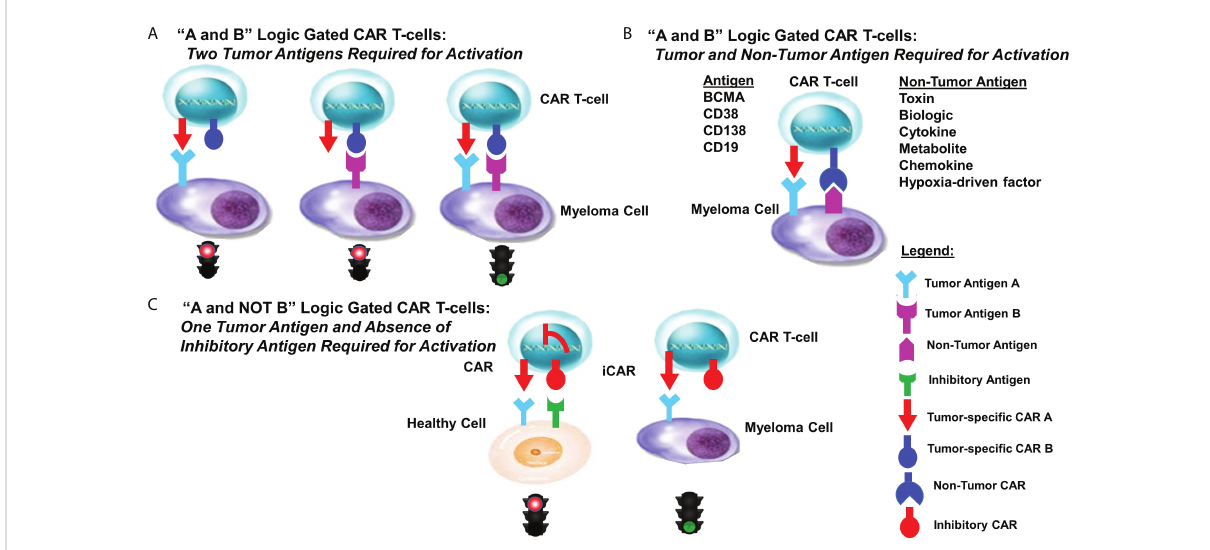
FIGURE 2 Logic-gated CAR T-cell design strategies. Shown are various designs for logic-gated CAR T-cells. (A) “ A and B ” logic-gated CAR T-cell design “ A and B ” Logic Gated CAR T-cells: Two Tumor Antigens Required for Activation. Tumor cells express two distinct tumor-speci fi c antigens. CAR T- cells express two separate CARs that each are required to recognize and bind a single tumor antigen. Binding of a single antigen alone does not promote CAR T-cell activity. The two distinct CARs are co-expressed with complementary signaling domains in one T-cell that fully activates the T-cell only in the presence of both cognate antigens. (B) “ A and B ” Logic Gated CAR T-cells: Tumor and Non-Tumor Antigens Required for Activation. Tumor cells express one tumor-speci fi c antigen as well as a non-tumor antigen. CAR T-cells are designed to express two separate CARs that each are required to recognize and bind a single antigen. Binding of a single antigen alone does not promote CAR T- cell activity. (C) “ A and NOT B ” Logic Gated CAR T-cells: One Tumor Antigen and the Absence of an Inhibitory Antigen Required for Activation. Inhibitory CARs (iCARs) are not able to adequately activate cytotoxic activity upon recognition and binding cells that express one of the two targeted antigens. iCAR-T cells selectively kill target cells that express only one antigen, whereas healthy (off-target) cells co-expressing another inhibitory ligand recognized by the iCAR are protected, allowing T-cells to distinguish target cells from healthy (non-tumor)